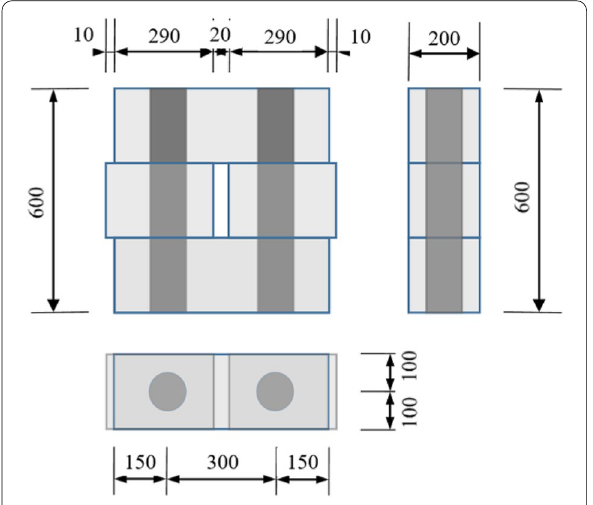
Fig. 4 Masonry specimens for shear tests. Table 2 Mechanical parameters of the shear specimens.